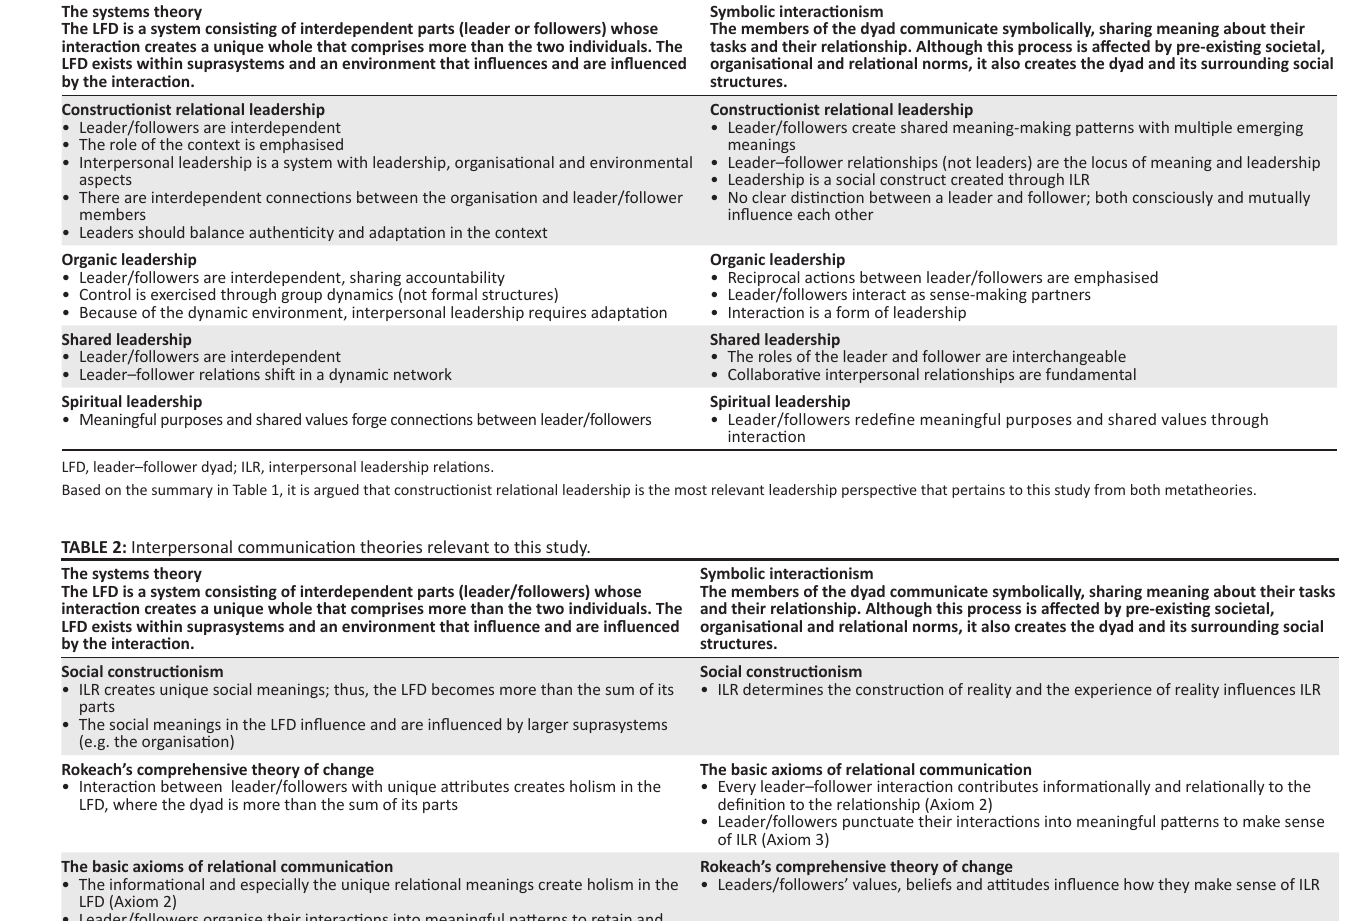
TABLE 1: Leadership perspectives relevant to this study.